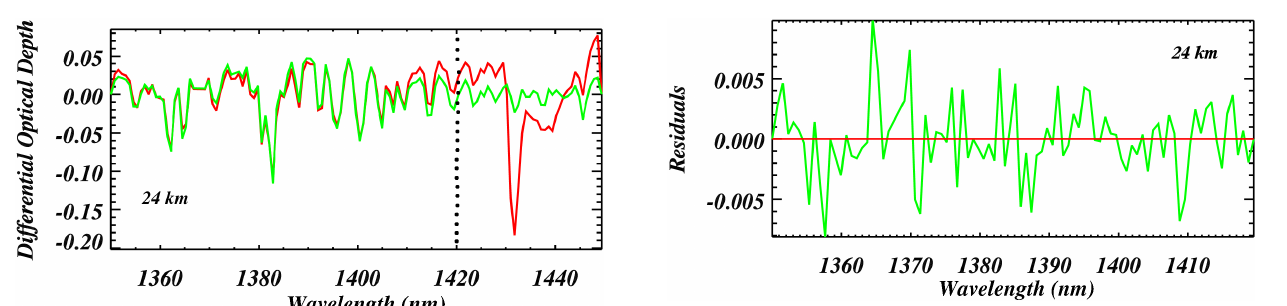
Fig. 5. Spectral plot for the wavelength window 1350–1450nm and 24km tangent height: Red line is the measured water va- por differential absorption spectrum. Green line is the correspond- ing modelled differential optical depth. A strong CO 2 absorption line is present around 1430nm. Wavelength section 1350–1420nm was selected for the retrieval (Measurement: 13 March 2006, or- bit=21085, SZA=109.137, moon phase=0.93).